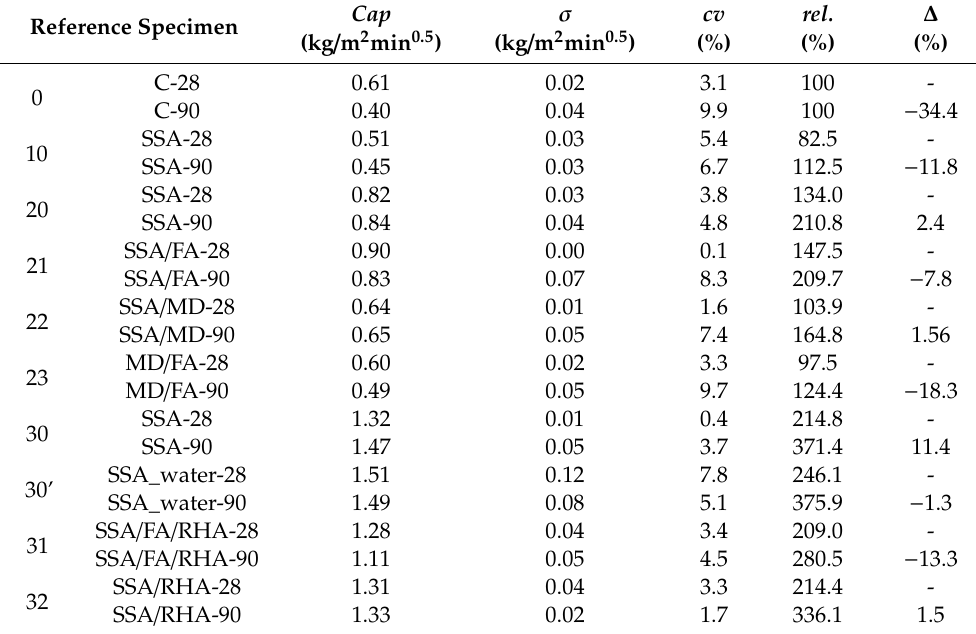
Table 5. Cap after four-hour test in specimens cured for 28 and 90 days ( σ : standard deviation, cv : coe ffi cient of variation, rel : relative value compared to control specimen with same curing age, ∆ : increase in each mixture between the two curing